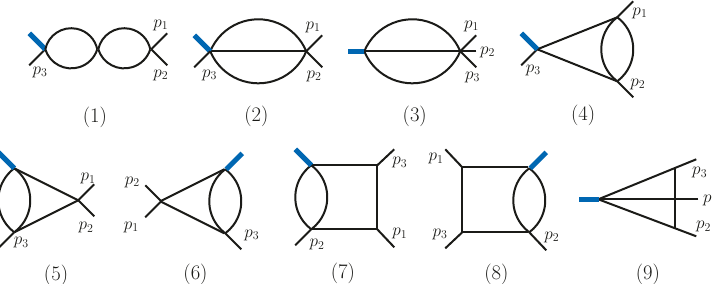
Figure 2 . Master integrals (plus their cyclic permutations) that contribute to planar two-loop minimal form factors of length-3